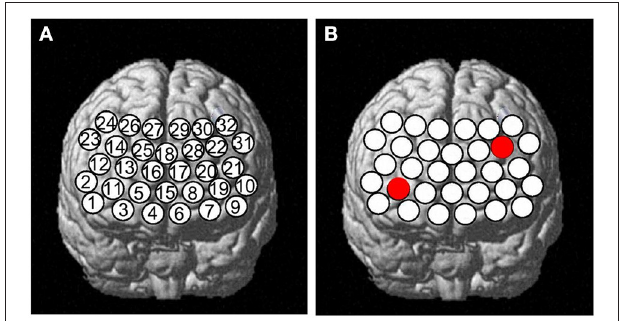
FIGURE 4 | The time course of mean hemodynamic changes ( Z -values) of 32 channels during the VFT task. The ordinate is the mean hemodynamic changes ( Z -value, *10 − 1 mmol.mm), and the abscissa is the time course of the task. HCs (red); MDD patients (blue); SZ patients (black).